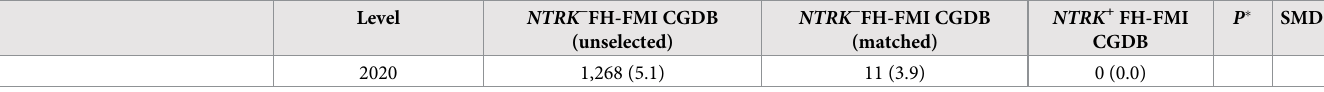
Abbreviations: CNS, central nervous system; ECOG PS, Eastern Cooperative Oncology Group performance status; FH-FMI CGDB, Flatiron Health–Foundation Medicine clinicogenomic database; NTRK - , neurotrophic tropomyosin receptor kinase fusion-negative; NTRK + , neurotrophic tropomyosin receptor kinase fusion- positive; SMD, standardized mean difference; SD, standard deviation. � For NTRK + versus matched NTRK − populations.